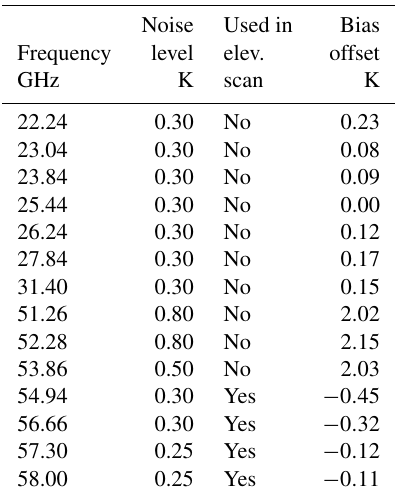
Table 2. Centre frequencies, assumed noise level, whether the ele- vation scans for the frequency are included in the observation vec- tor, and the bias offset applied to the observations for the HATPRO MWR at Summit.